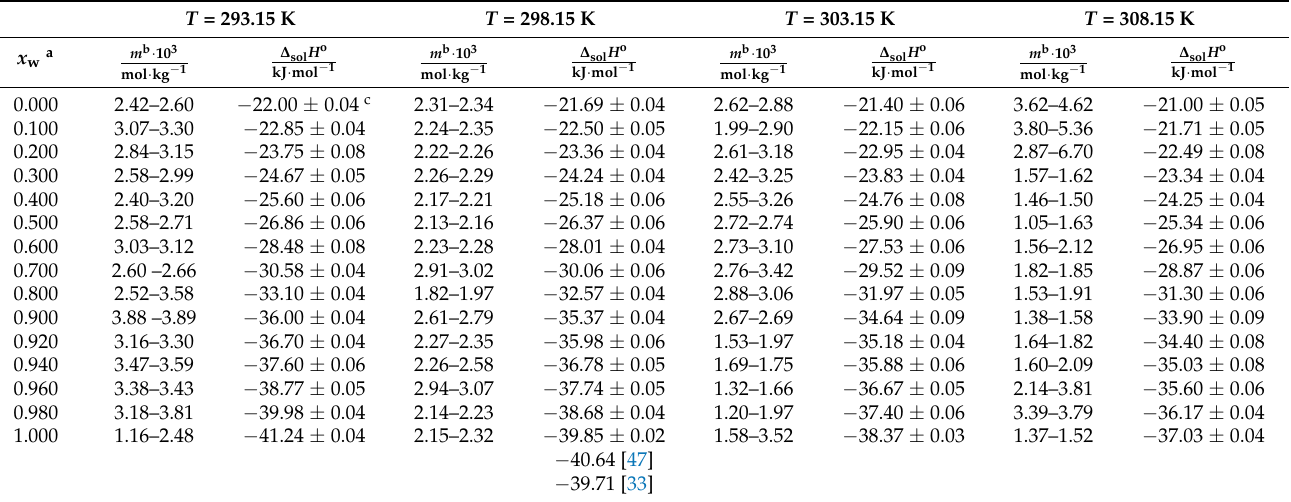
Table 5. Standard molar enthalpy of solution ( ∆ sol H o ) and molality ( m ) of 15C5 in the F + W mixtures at T = (293.15, 298.15, 303.15, 308.15) K.